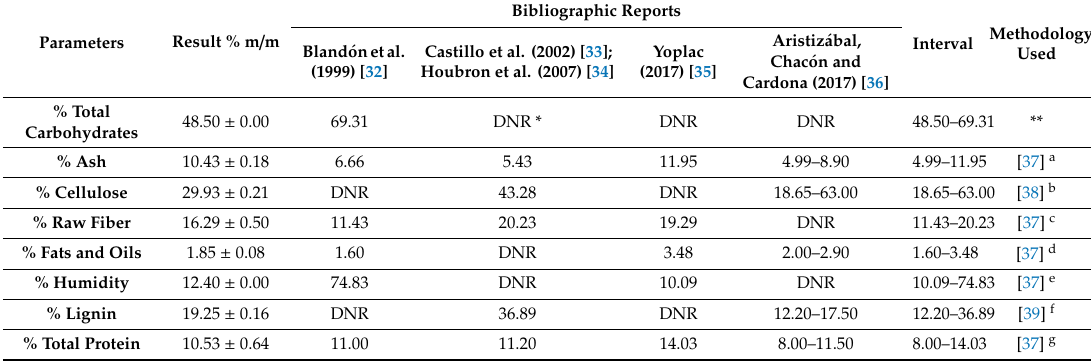
Bibliographic Reports